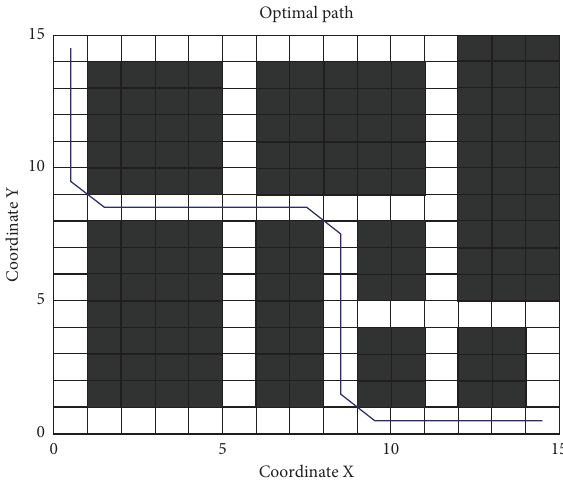
Figure 4: Te optimal path of the improved ant colony